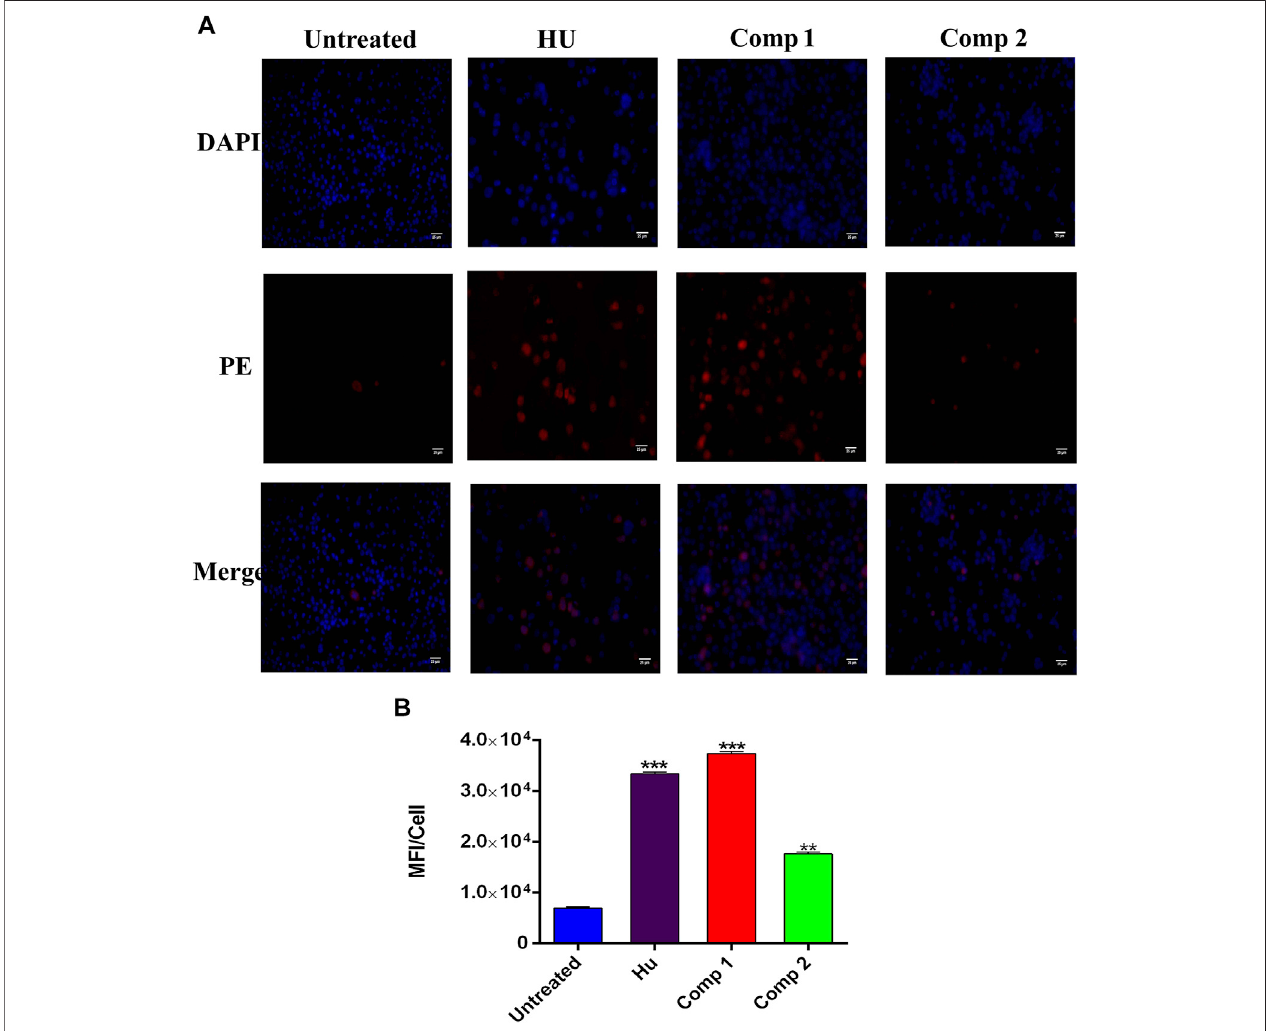
FIGURE 6 | Immuno fl uorescence analysis K562 cells treated with compound 1 (0.1 µM), compound 2 (1 µM), and HU (200 µM) showed HbF expression in comparisontountreatedcells. (A) ThePEpanelshowedthattreatedcompoundsexhibitedstronger fl uorescentsignalsthantheuntreatedculture.Cellswereco-stained with DAPI for visualization and the pink color in the merge panel indicated the co-localization. (Scale bar = 25 µM). (B) Mean fl uorescence intensity (MFI)/cells were calculated by ImageJ ver. 4.1.0. * p < 0.05 was considered statistically signi fi cant HbF expression in comparison to control.